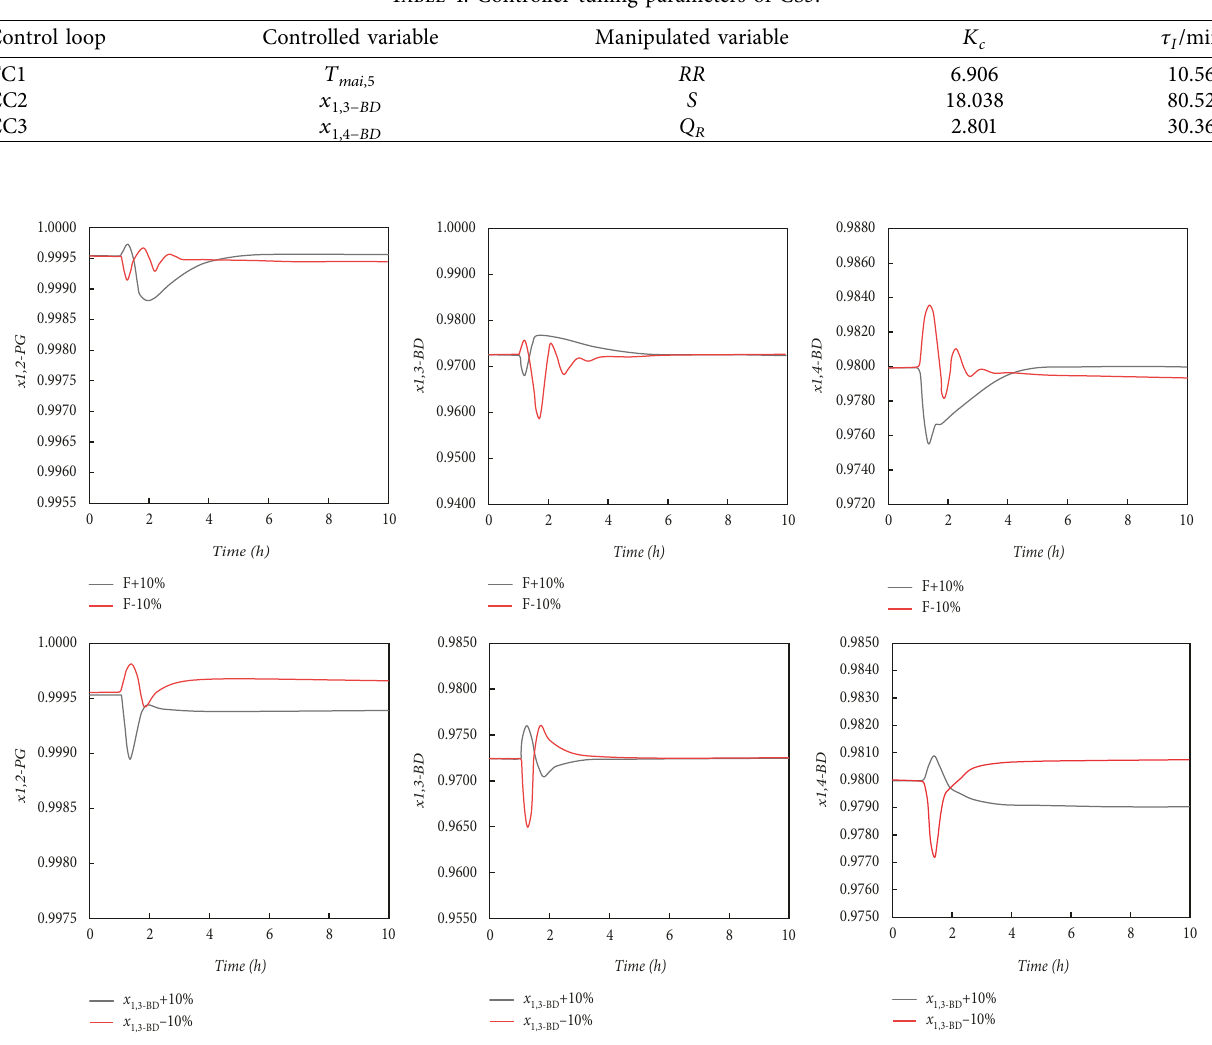
Figure 8: Dynamic responses of CS3 to ± 10% feed